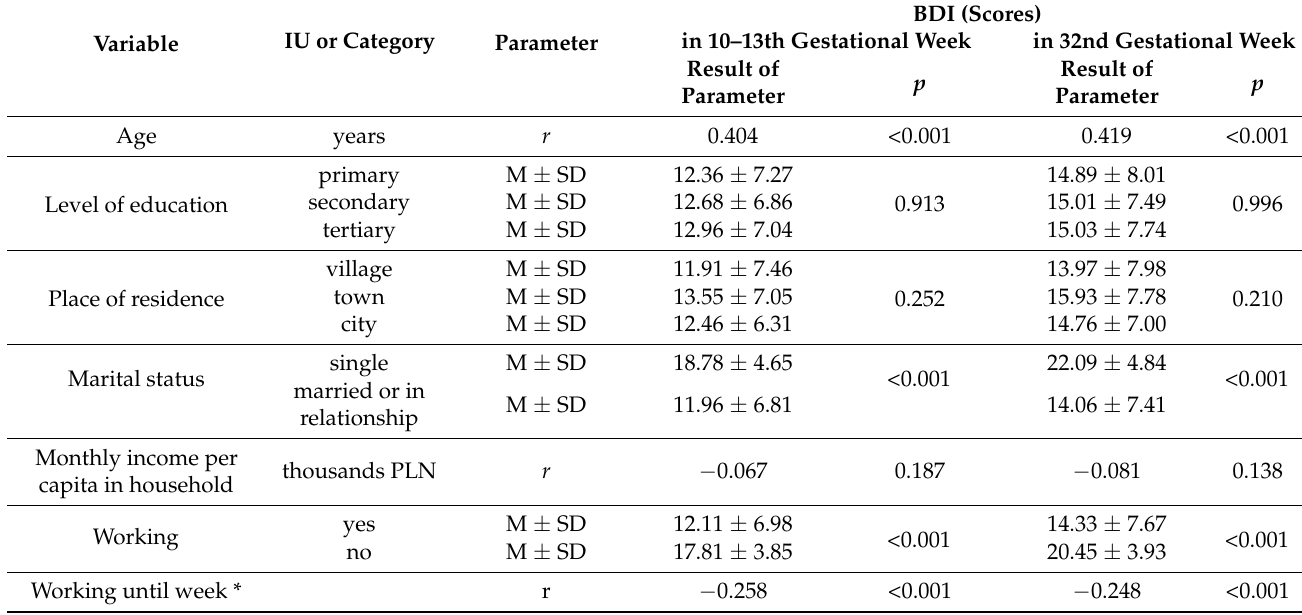
Table 2. Severity of depression against socio-economic